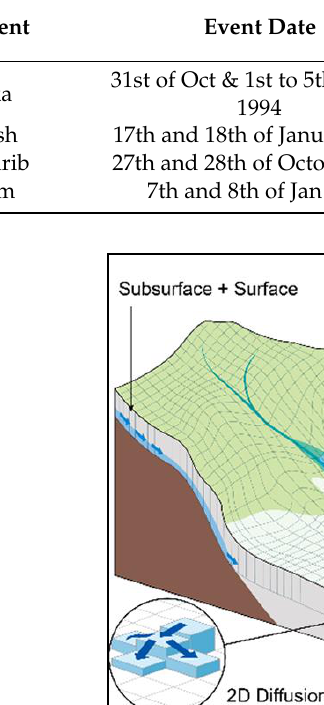
Table 1. Flash flood events used for the rainfall-runoff-inundation (RRI) model.